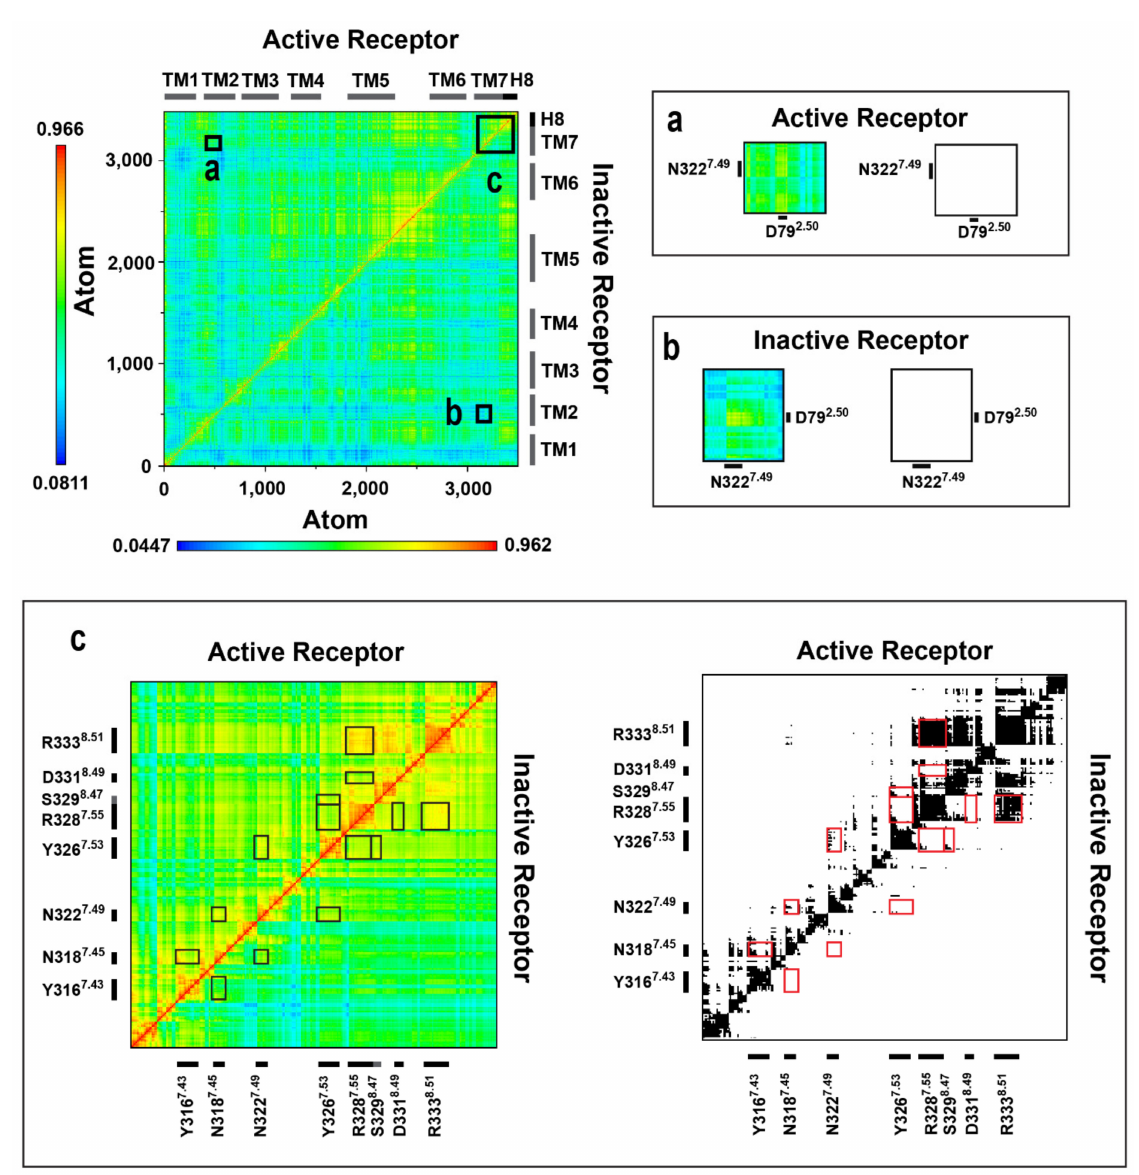
Figure 5. Dynamic cross-correlation matrices of the G s protein-bound β 2 AR in active and inactive states. Panels ( a – c ) are magnified views of regions of amino acid residues of interest. Black and white panels show correlations above the threshold of 0.65